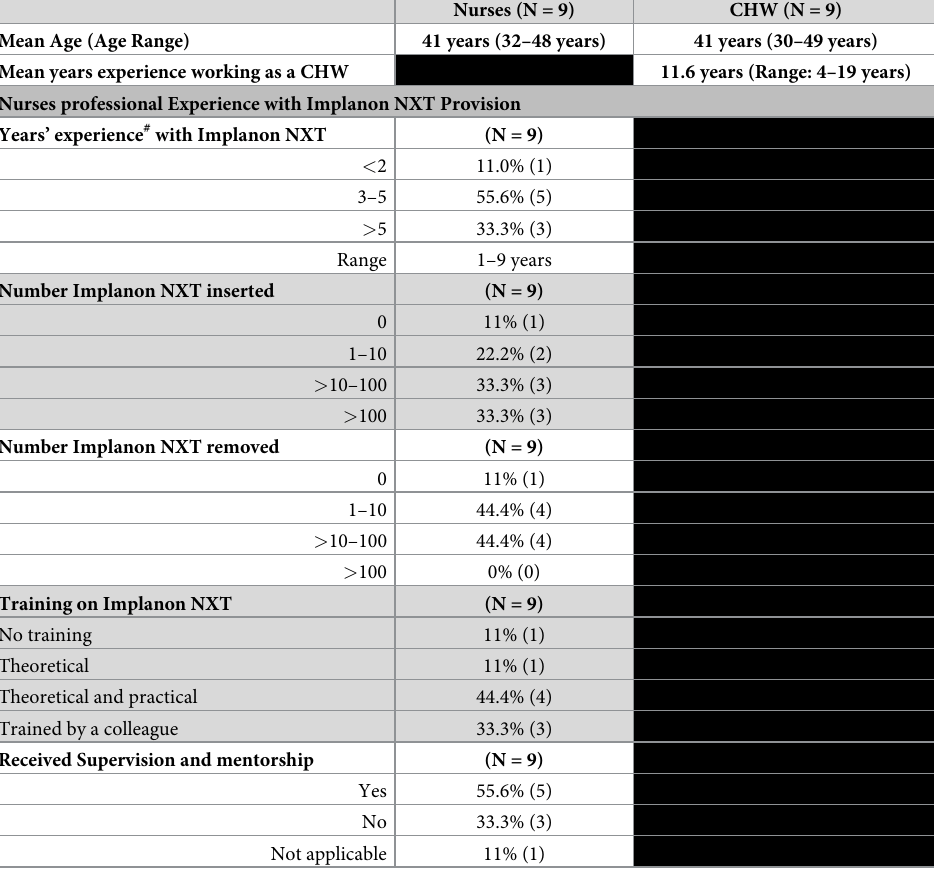
Table 1. Demographic and experience details for nurses and CHWs working in Rural